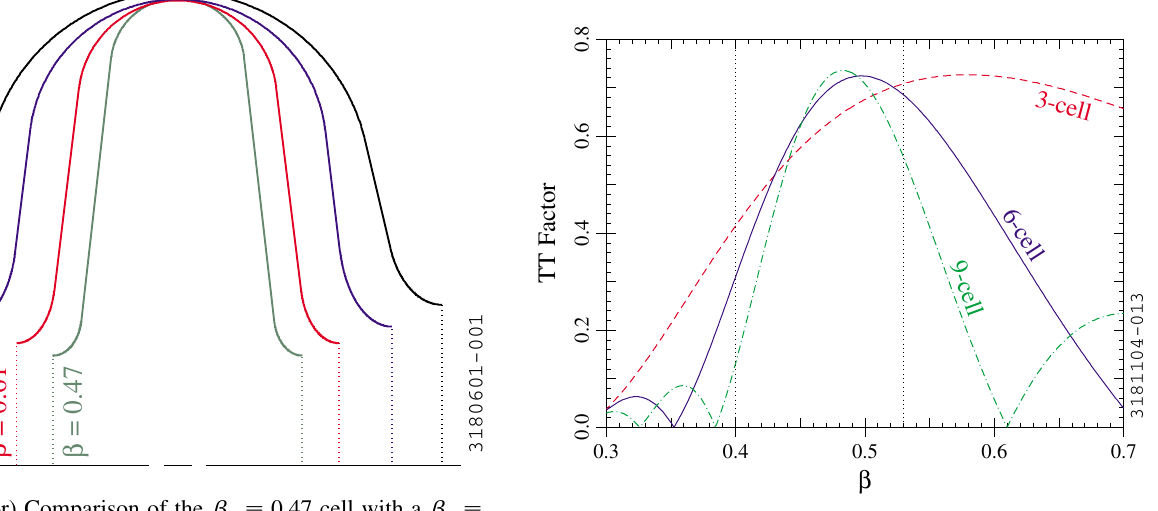
(cid:7) 0 : 47 cell with a (cid:6) (cid:7) g g (cid:7) 0 : 81 cell (SNS), and a (cid:6) (cid:7) 1 cell FIG. 2. (Color) Dependence of the transit time factor on (cid:6) for g g (cid:7) 0 : 47 cavity for 3, 6, and 9 cells. the (cid:6) g